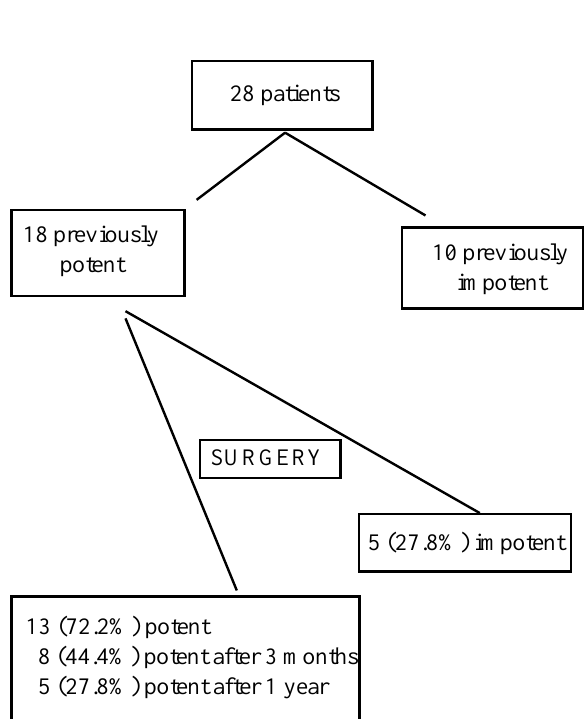
Figure 1 – Sexual function of patients undergoing extraperitoneal endoscopic radical prostatectomy with duplication of open tech-